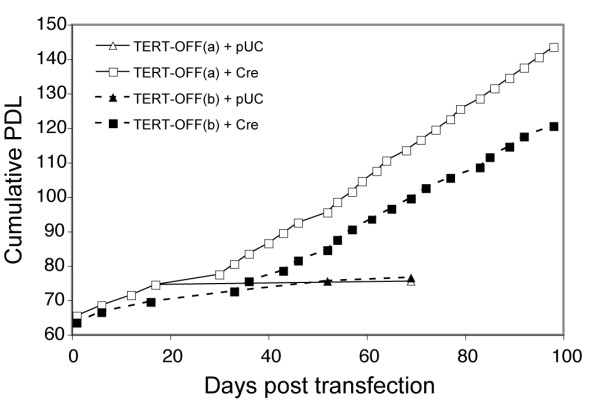
Strict control of cellular immortalization via the hTERT binary vector. After introduction of a binary expression vector containing hTERT in the 'OFF' state, two clonal populations were selected, hTERT-OFF(a) (open symbols) and hTERT-OFF(b) (filled symbols). These distinct cell populations then underwent transient transfection with a control vector, pUC (triangles), or a vector expressing Cre-recombinase (squares). Note that only the cells in which Cre recombinase was introduced became immortalized (squares). The x-axis indicates the number of days, and the y-axis shows cumulative population doublings (PDL).